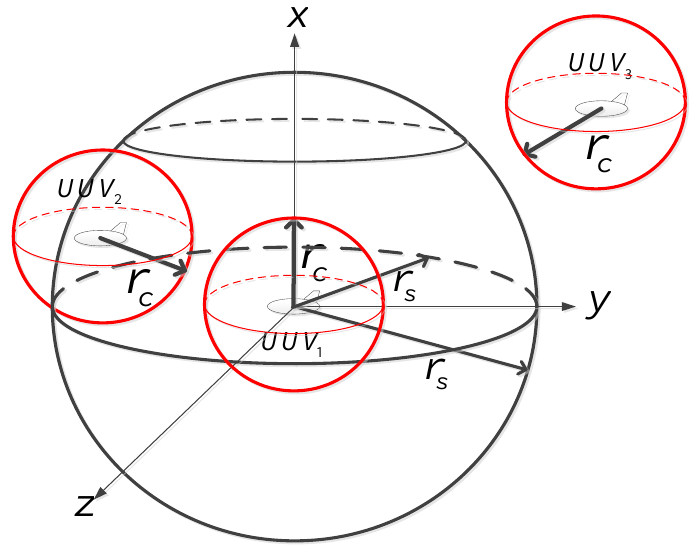
Figure 2. Collision sphere and the collision avoidance sphere of UUVs.